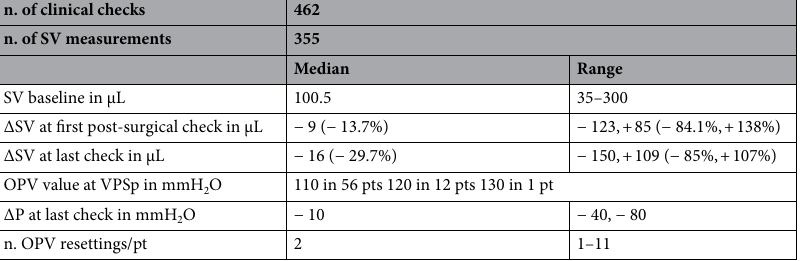
Table 1. Imaging and opening pressure valve data at baseline and during follow-up in 69 idiopathic normal pressure hydrocephalus patients who underwent ventriculoperitoneal shunt placement with adjustable valve. n. number; OPV opening pressure valve; pt(s) patient(s); SV aqueductal cerebrospinal fluid stroke volume; VPSp ventriculoperitoneal shunt placement. Clinical check indicates the clinical evaluation, possibly associated with SV measurement and/or OPV resetting; ∆SV indicates the difference between SV values at baseline and during follow-up; ∆P indicates the difference of OPV setting at surgery and during follow-up.